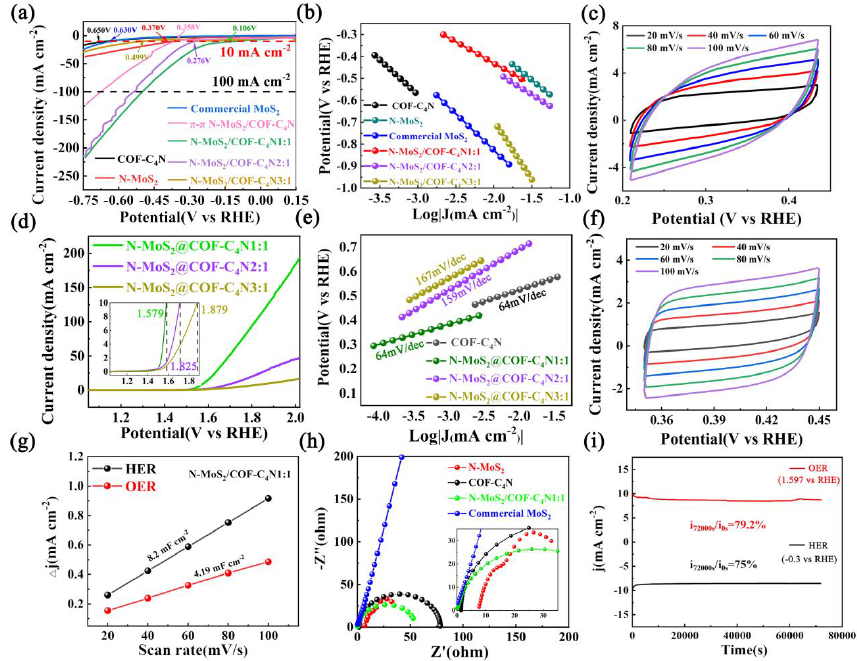
Figure 4. HER and OER performance. ( a ) The HER LSV curves of the commercial MoS 2 , N-MoS 2 , COF-C 4 N, and the vertical N-MoS 2 /COF-C 4 N. ( b ) The corresponding HER Tafel plots. ( c ) The CV curves of the vertical N-MoS 2 /COF-C 4 N in 0.5 M H 2 SO 4 saturated with N 2 . ( d ) The OER LSV curves of the vertical N-MoS 2 /COF-C 4 N. ( e ) The corresponding OER Tafel plots. ( f ) The CV curves of the vertical N-MoS 2 /COF-C 4 N in 1 M KOH saturated with N 2 . ( g ) Capacitive currents versus scan rates on the basis of CV curves recorded at different scan rates. ( h ) EIS Nyquist plots of the commercial MoS 2 , N-MoS 2 , COF-C 4 N, and the vertical N-MoS 2 /COF-C 4 N. ( i ) Chronoamperometric durability test of the vertical N-MoS 2 /COF-C 4 N at 0.3 V in 0.5 M H 2 SO 4 for HER and at 1.579 V in 1 M KOH for OER.